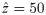
Visualization of F(z) in the conceptual model.F(z) denotes the copy number of a cell right before division that did start with z (β0 = b = 1/h, z^=50). As F(z) is concave, F(z/2) > {F((1 + a)z/2) + F((1 − a)z/2)}/2.